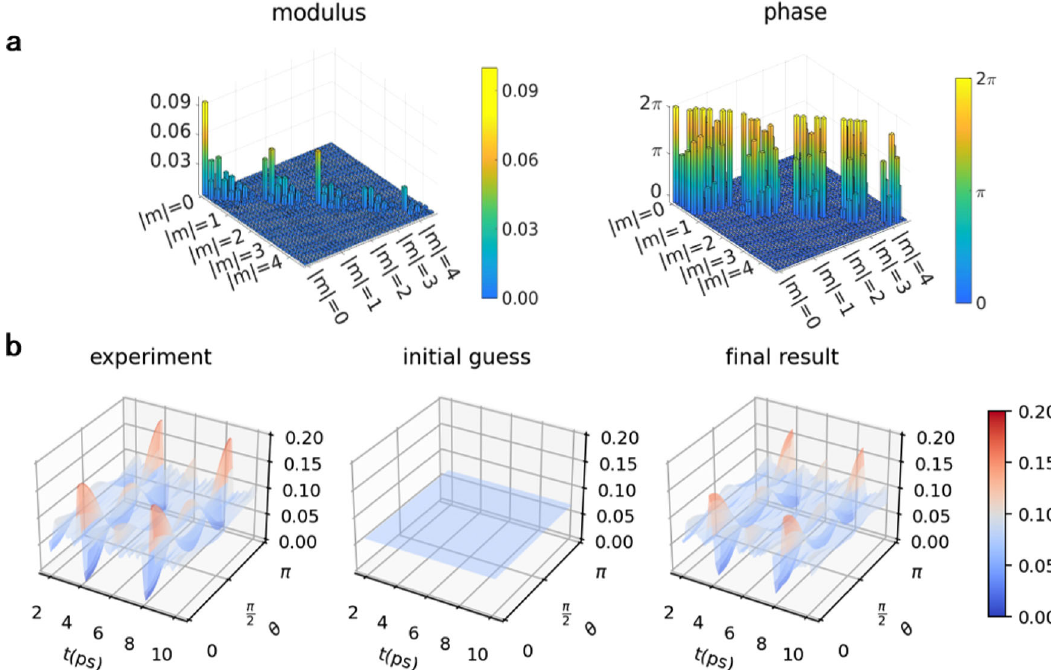
Fig. 5 Experimental quantum tomography of rotational wavepacket of nitrogen molecule. a The moduli and phases of QT retrieved density matrix elements. Within each m -block J ¼ j m j ; j m j þ 1 ; (cid:4)(cid:4)(cid:4) ; J max (phases are plotted at t = 1.95 ps after the alignment pulse). The density matrix elements of opposite magnetic quantum numbers m and − m are identical (see Supplementary Eq. 21). Density matrix elements of higher m -blocks are not plotted due to their small moduli. b The wavepacket probability distribution Pr( θ , t ) (cylindrically symmetric in azimuthal direction of ϕ ) of experimental data, initial guess and fi nal result of